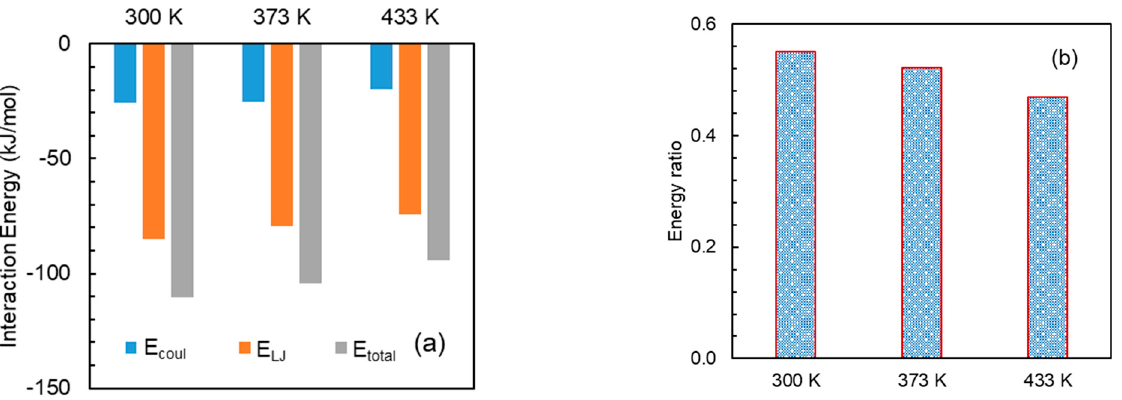
Figure 12. ( a ) Interaction energies between DMF and HPMC(AS), and ( b ) energy ratio: DMF– HPMC(AS)/DMF–DMF at temperatures of 300, 373, and 433 K.